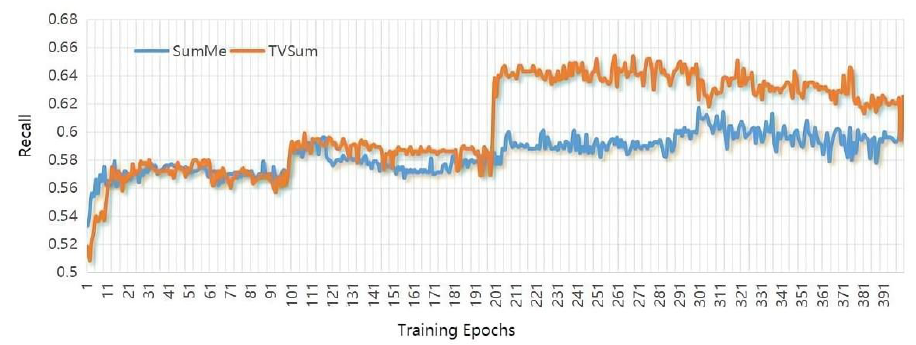
Figure 5. Plots show the influence of training epochs on the value of